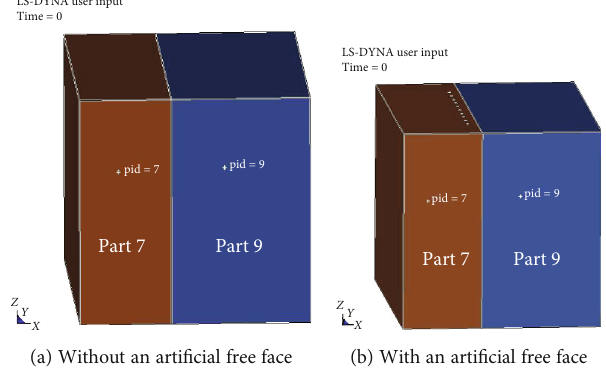
Figure 12: Bedrock model composition.